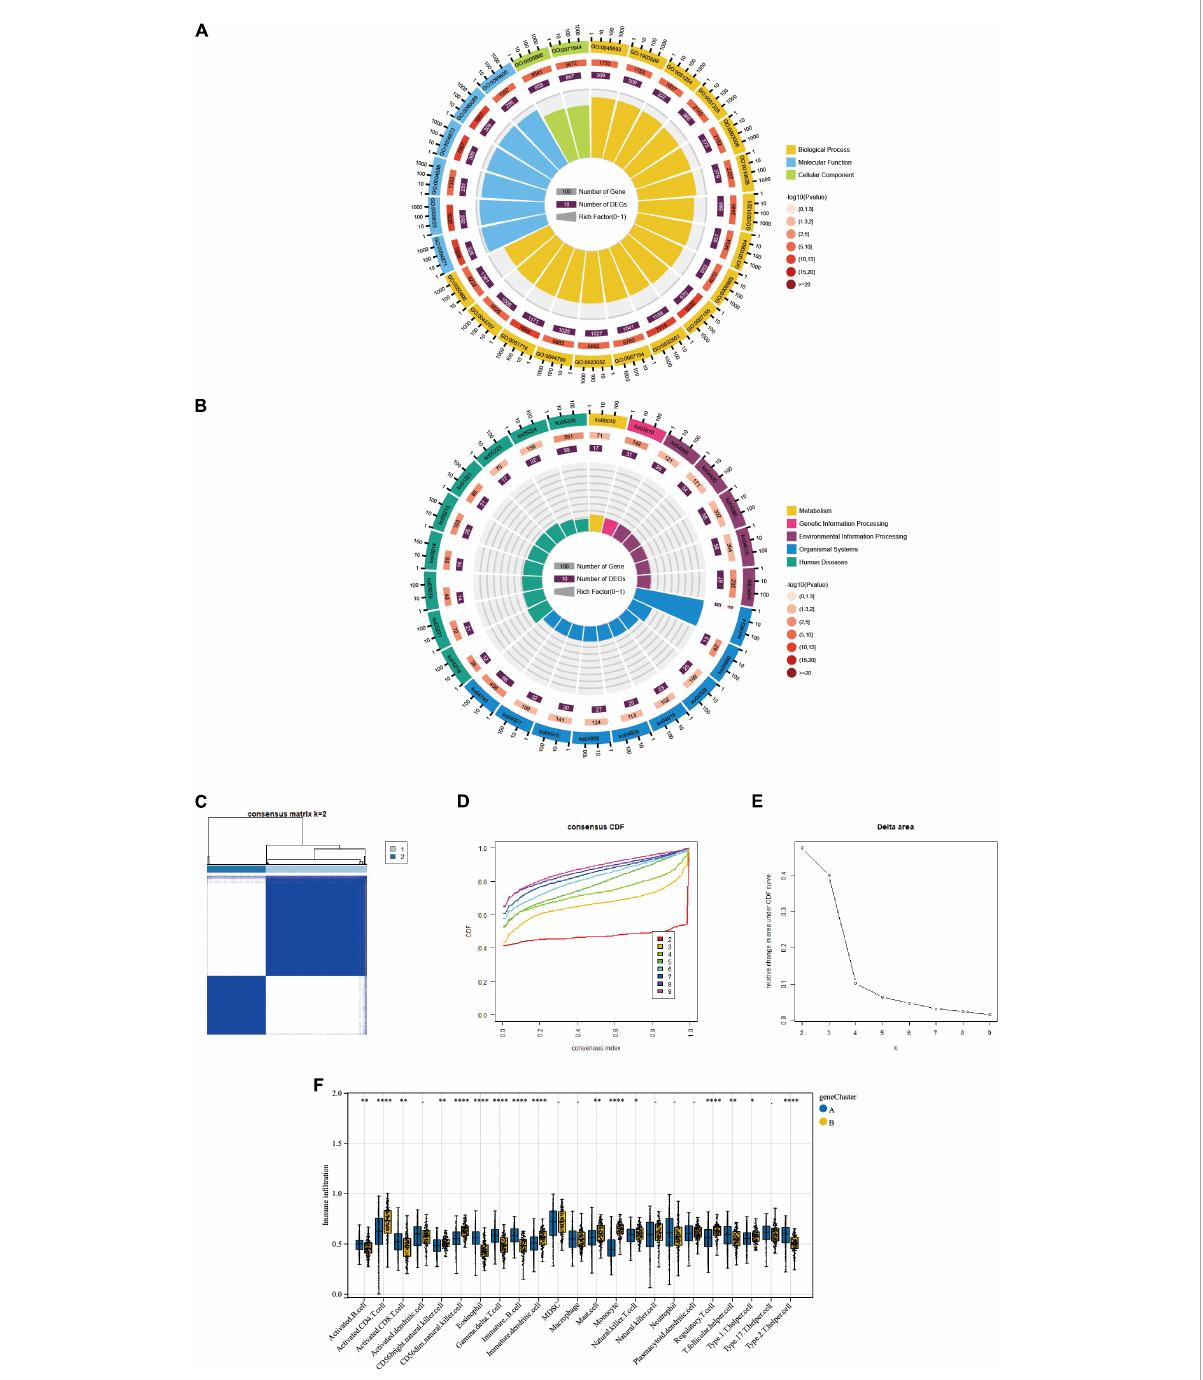
FIGURE6 (A,B) The GO enrichment and KEGG pathway analysis results of CDEGs are shown as circle plots. For enrichment analysis of the circle plot, the GO id (or pathway id) label of the first circle corresponds to the “id” of the result data ( Supplementary Table 1 ), and The “class” of the result data corresponds to the colour of the grouping. The length of the bar in the second circle corresponds to the “bg_num” of the resulting data, i.e., the number of background genes, and the shade of the colour corresponds to the P -value (or Q value). The third circle corresponds to the “fg_num” of the resulting data, i.e., the number of foreground genes. The fourth circle (polar bar) shows the Rich factor, obtained by dividing fg_num and bg_num and corresponds to the data in the ratio column of “ Supplementary Table 1 ”. (C) Cluster-heatmap. (D) Cumulative distribution function (CDF). (E) Delta area plot. (F) Comparison of the percentage of immune cell infiltration between geneCluster A and B; Blue represents FRGcluster A; yellow represents FRGcluster B. ∗ P < 0.05; ∗∗ P < 0.01; ∗∗∗∗ P < 0.001. CDEGs, cluster differential expressed genes; GO, Gene Ontology; KEGG, Kyoto Encyclopedia of Genes and Genomes; CDF, cumulative distribution